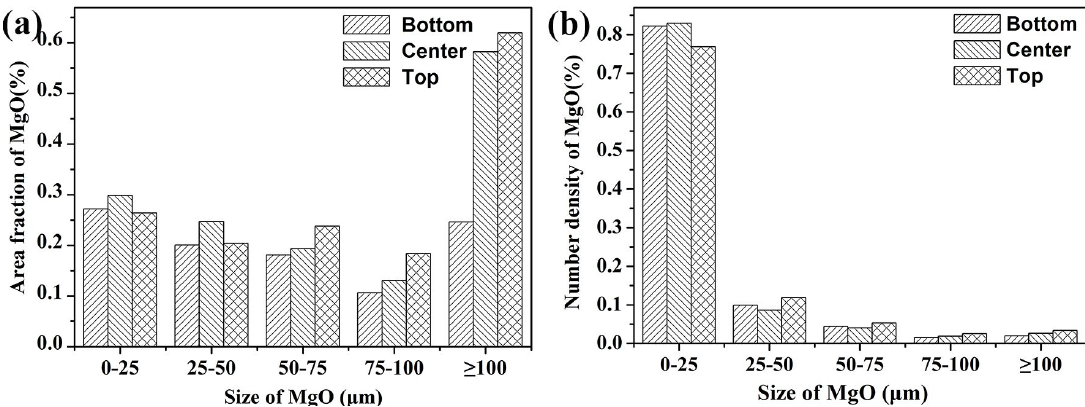
Figure 3. The area fraction and the number density of the MgO in the different size range: (a) the area fraction of the impurity phases in the different size range; (b) the number density of the MgO in the different size with the size larger than 100 μm was only 0.25%, and it was lower than the top and center region ingot. The total area fraction of MgO from the top to the bottom ingot was 1.51%, 1.45% and 1.01%, respectively. These data indicated that the area fraction, number and size of MgO reduced from the top to the bottom of ingot. The coarser MgO mainly appeared in the top region of ingot and the bottom region’s impurity phase size was relatively small and uniform.